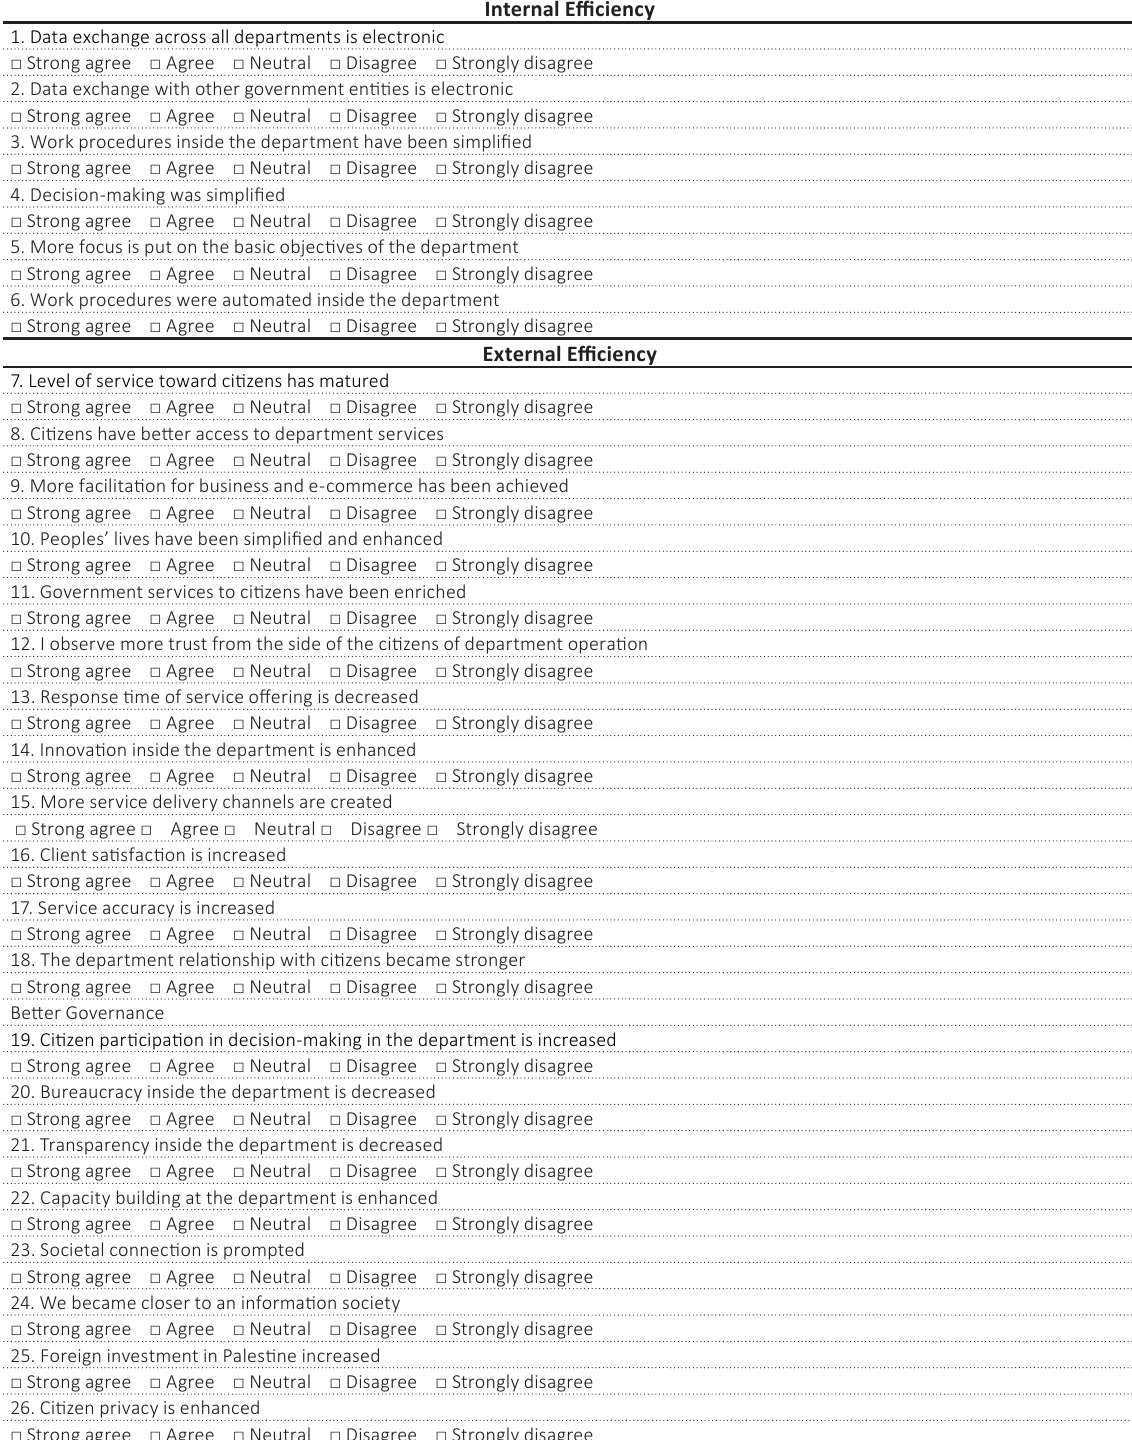
Table A1. Questionnaire (Translated from Arabic)